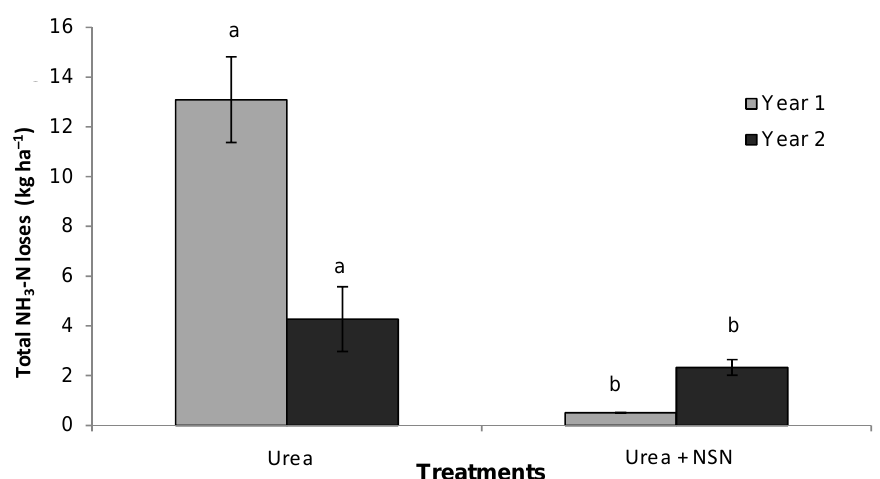
Figure 3. Total N loses from urea and urea treated with NSN (urea + NSN) applied broadcast on the surface to no till corn during two years. Within the years, means followed by the same letter are not significantly different from each other based on the LSD test (0.05). Vertical bars indicate standard error. NSN, maleic itaconic acid.